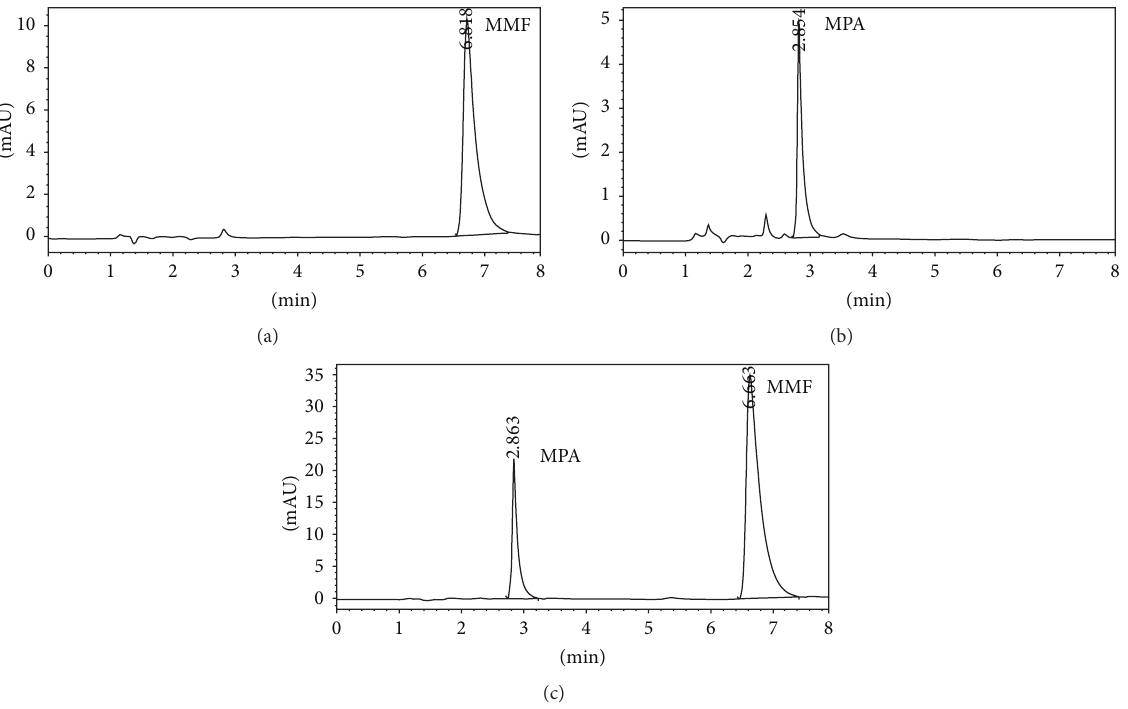
Figure 3: Chromatogram of MMF (a), MPA (b), MMF, and MPA in donor solution